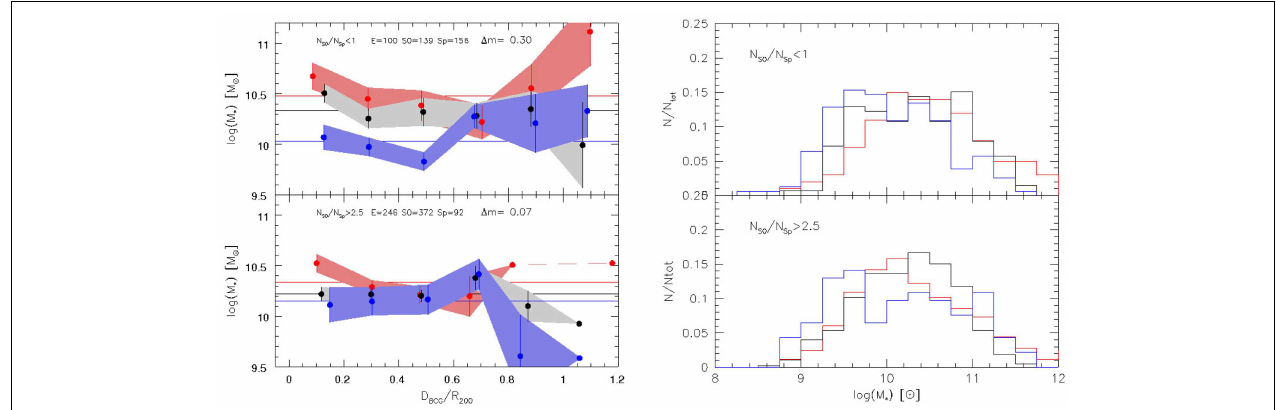
FIGURE 18 | Left: The masses of the three morphological types in clusters with a high and small ratio of S0’s to Spirals. Right: The distribution of the masses of the three morphological types in clusters with a different fraction of S0/Sp.